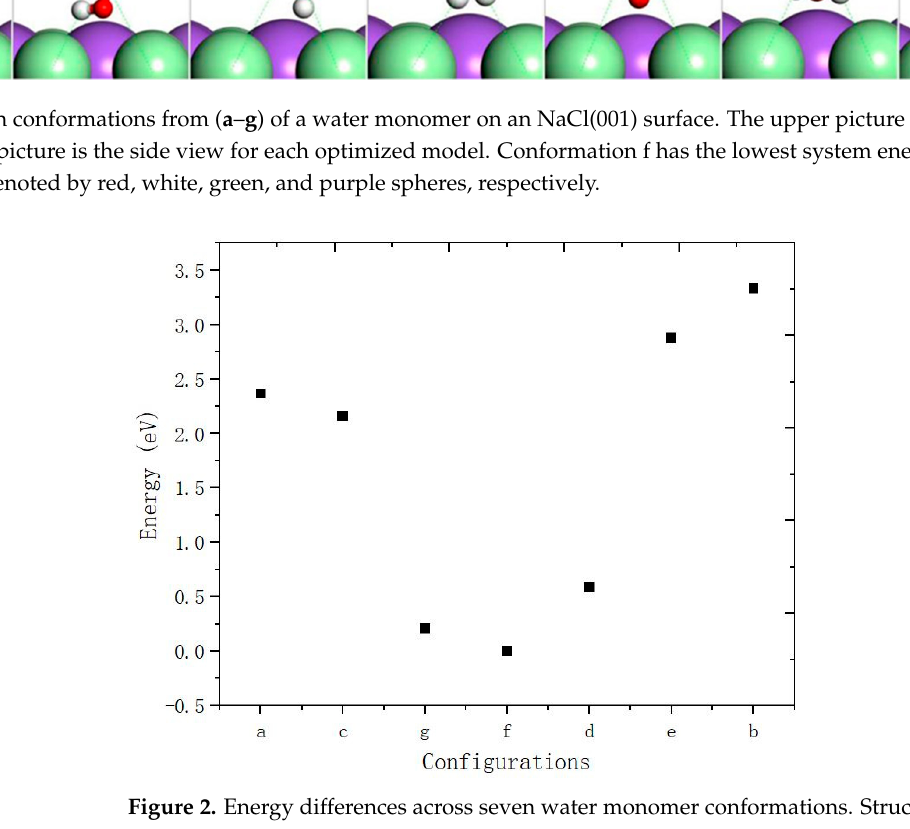
Figure 1. Seven conformations from ( a – g ) of a water monomer on an NaCl(001) surface. The upper picture is the top view and the lower picture is the side view for each optimized model. Conformation f has the lowest system energy. O, H, Cl − , and Na + are denoted by red, white, green, and purple spheres, respectively. Table 1. Energy difference (E) and optimized structural parameters of the seven models. The low- est system energy of conformation f was taken as the reference point. The two nearest H–Cl dis- tances are presented for comparison.